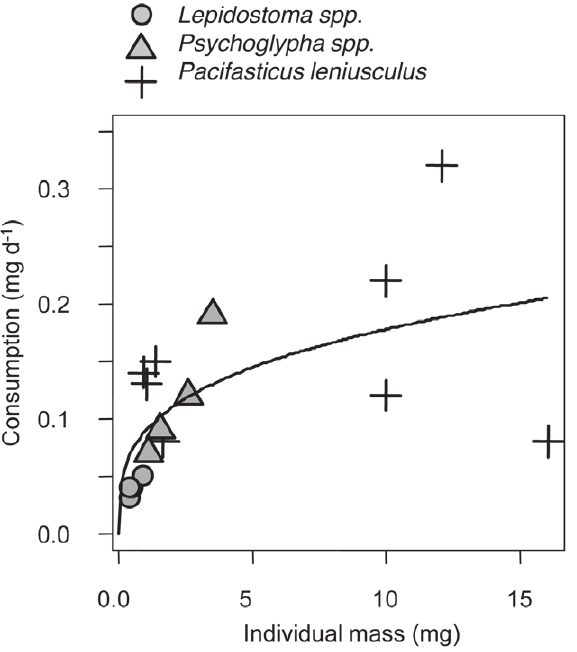
Figure 4. Ecosystem processes in the comparative study. Each point represents a different study pool. (a). Rate of algal accrual on elevated tiles. The gray polygon denotes the 95% confidence interval. (b). Rate of breakdown of leaves. Also shown in this panel in the open polygon and dashed line is the prediction interval and predicted line from the 2008 experimental relationship between leaf litter breakdown rate and crayfish.